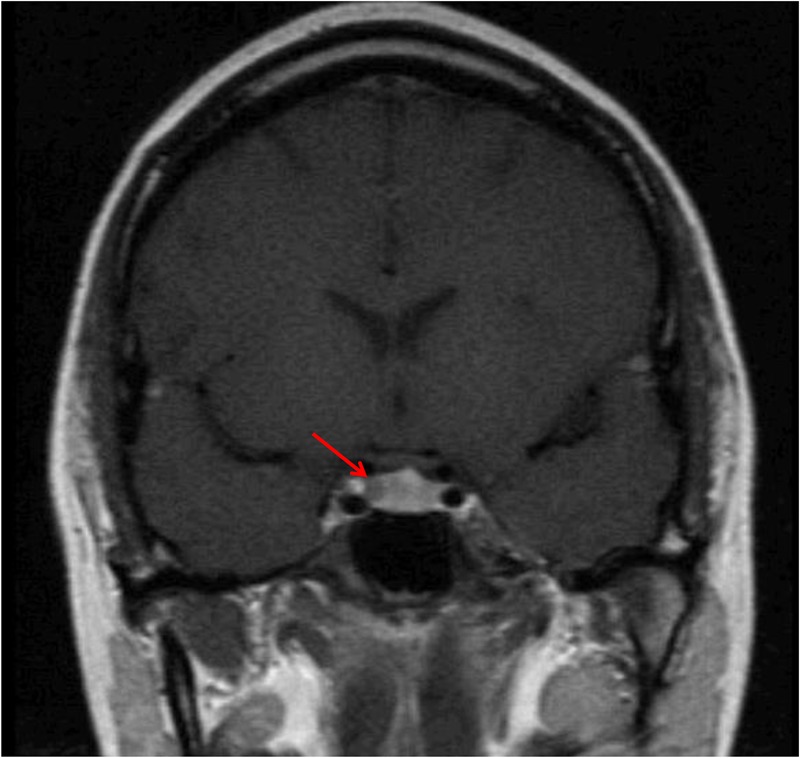
Pituitary magnetic resonance imaging (MRI) coronal image confirmed a right-sided sellar hypointensity consistent with a 4-mm pituitary adenoma.